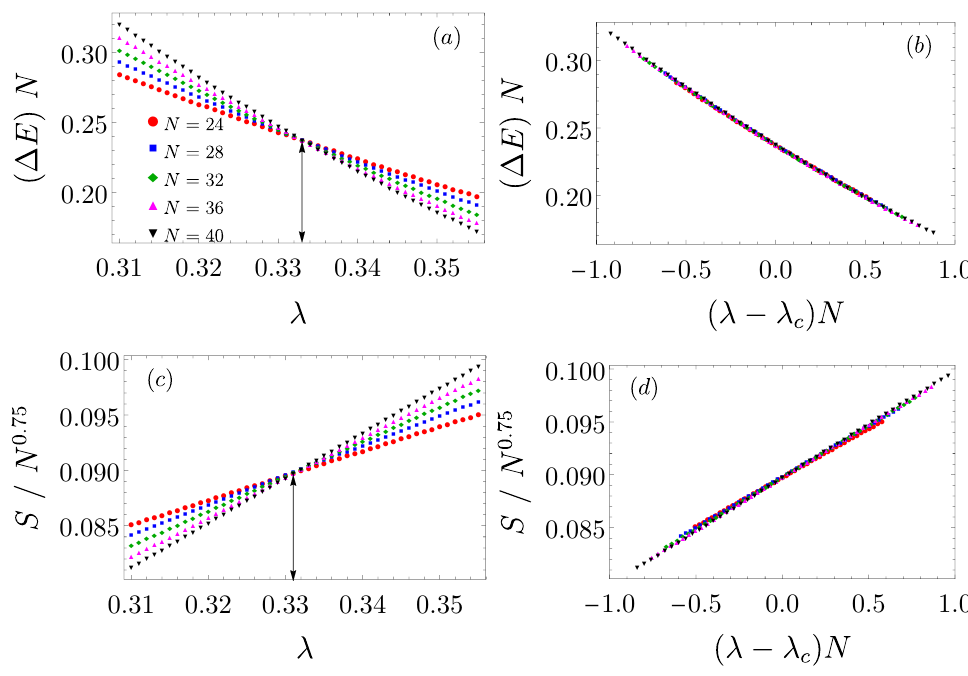
Figure 3: (a): Plot of ( ∆ E ) N z for a two-leg ladder as a function of λ for w = 0.05 for ≃ 0.333 for z = 1. (b) Plot of ( ∆ E ) N z as a several N showing a crossing at λ = λ c ) showing perfect scaling collapse for z = ν = 1. (c): Plot of function of N 1 /ν ( λ − λ c ≃ 0.331 for η = 0.25. (d) Plot SN 2 − z − η as a function of λ showing a crossing at λ c ) N 1 /ν showing perfect scaling collapse for ν = 1 of SN 2 − z − η as a function of ( λ − λ c and η = 0.25. All energies are scaled in units of ∆ . See text for